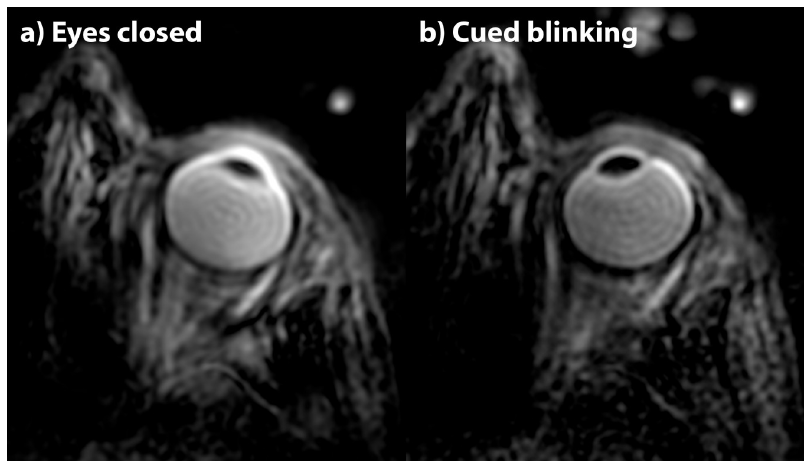
Fig 3. Sensitivity of magnetization-prepared ZTE imaging to eye motion. (a) transverse reformat of a T 2- prepared ZTE data set obtained in a volunteer instructed to keep the eyes closed during the entire scan. (b) reformat from the same volunteer using the same contrast preparation but during cued-blinking, instructing the volunteer keeping the eye open and focused to a defined spot during the segmented T 2 -prepared ZTE acquisition, with a pause to blink in between segments. No significant difference in image quality was found. The small bright spots on the outside of the head are the capacitors of the receive coil, which are generally not visible in MR-images due to their short T 2 . Although their water-content is small[22], the close proximity to the receive coil results a high signal intensity.